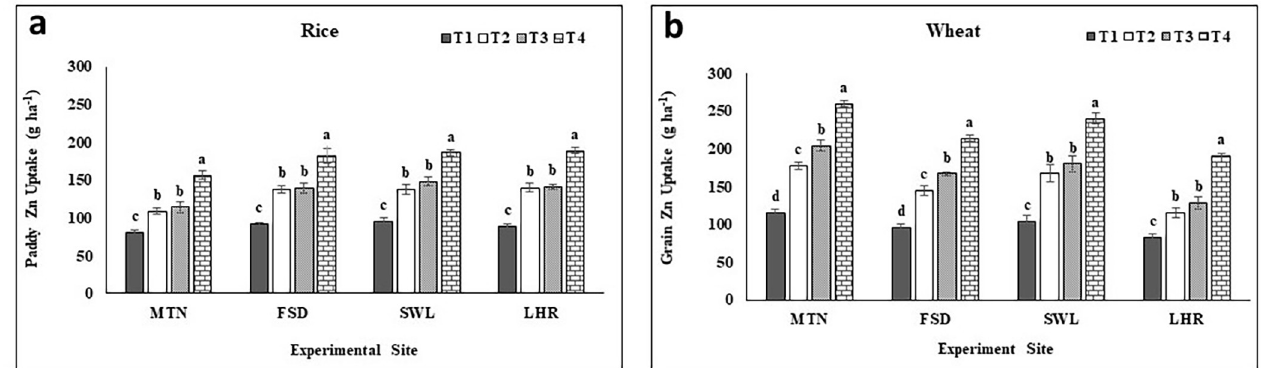
Fig 3. Effect of zinc sulfate and bioactive zinc coated urea on Zn uptake by paddy of rice and grains of wheat. MTN = Multan; FSD = Faisalabad; SWL = Sahiwal; LHR = Lahore; BAZU = Bioactive Zn coated urea (42% N; 1% Zn); T 1 (Urea 46% N @ 185 kg ha -1 + zero Zn), T 2 (Urea 46% N @ 185 kg ha -1 + ZnSO 4 33% Zn @ 15 kg ha -1 ), T 3 (BAZU 42% N @ 100 kg ha -1 + Urea 46% N @ 62 kg ha -1 + 1% bioactive Zn @ 1.00 kg ha -1 ), T 4 (BAZU 42% N @ 125 kg ha -1 + Urea 46% N @ 62 kg ha -1 + 1% bioactive Zn @ 1.25 kg ha -1 ).